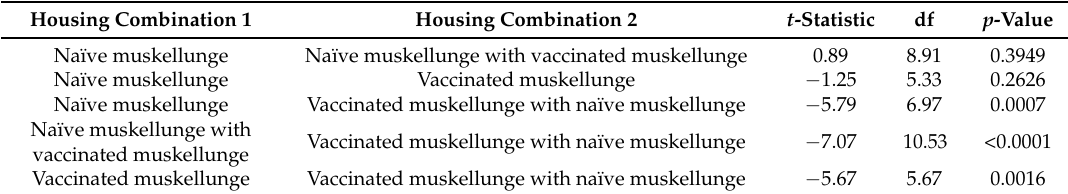
Table 4. Pairwise comparison of anti-VHSV-IVb antibody levels. Pairwise comparisons of circulating binding anti-VHSV-IVb antibody OD values in surviving muskellunge following VHSV-IVb exposure. OD values were modeled using a mixed effect model following log e transformation of the data. The t -statistic, degrees of freedom, and p -value are shown for each comparison.